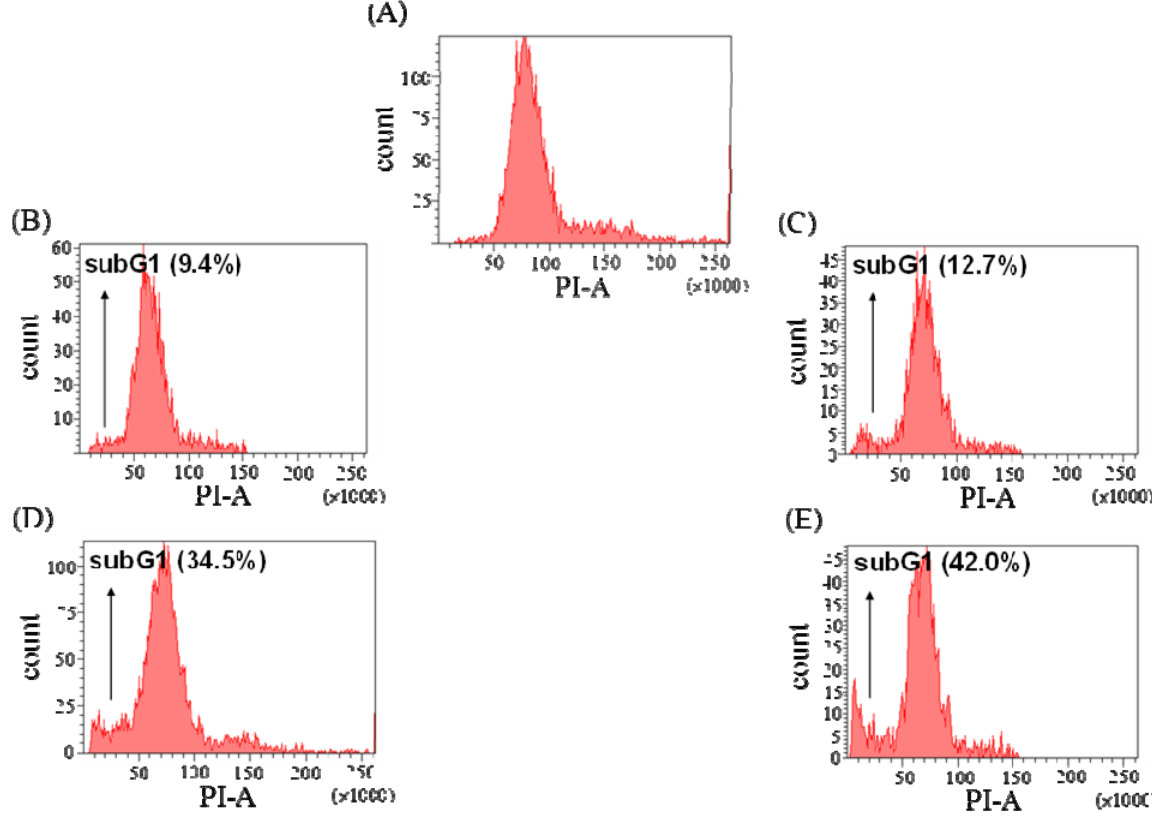
Figure 3. Effects of davallic acid on A549 apoptosis (sub G1 peak) after treatment for 12 h and 24 h, respectively. ( A ) control; ( B ) 10 μ M treatment for 12 h; ( C ) 20 μ M treatment for